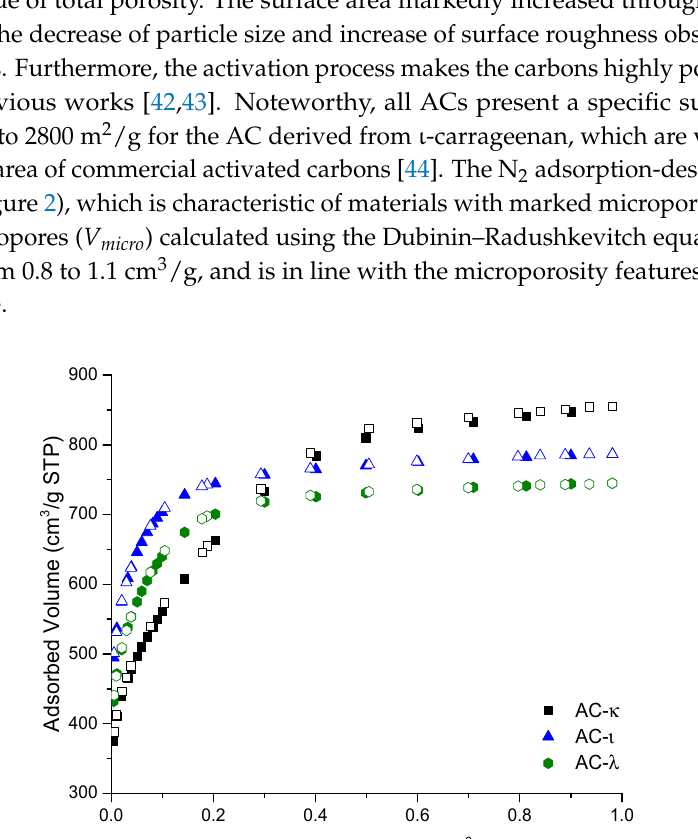
Table 2. Textural properties of the hydrochars and activated carbons.